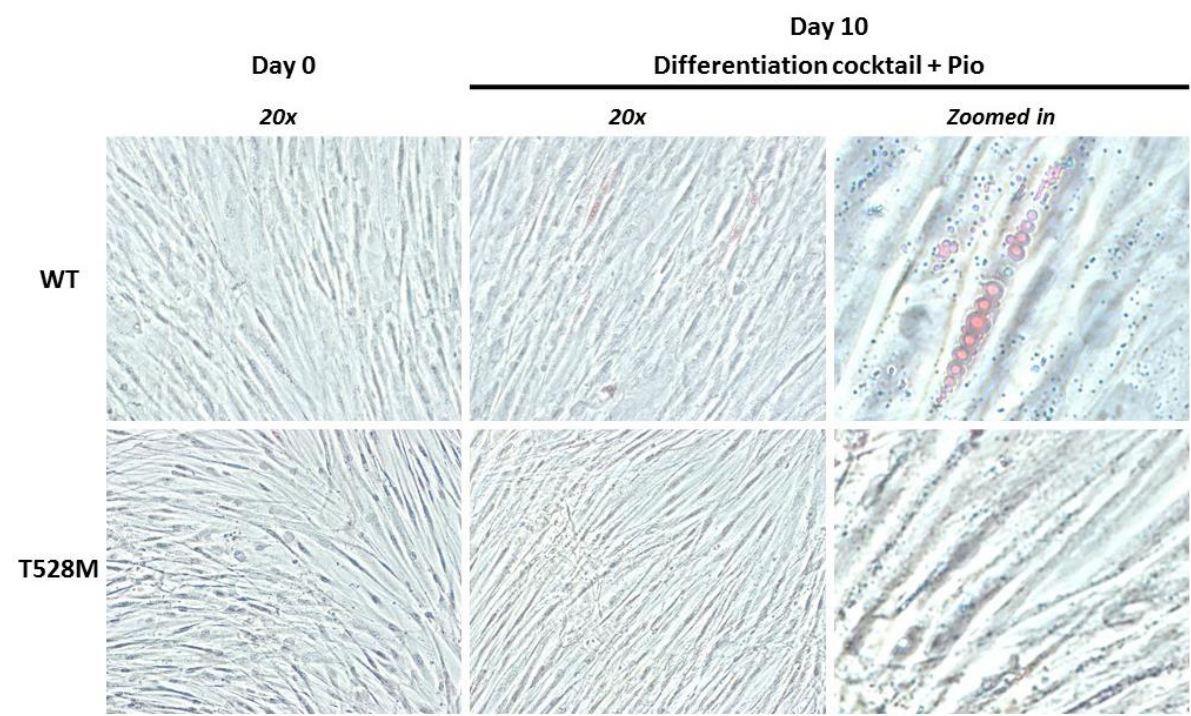
Figure 4. Representative photographs of lipid droplet formation in preadipocytes demonstrated by using Oil red O staining. Preadipocytes were induced for differentiation over 10 days into adipocytes with the differentiation cocktail containing pioglitazone. At day 10, after the induction of adipogenic differentiation, microphotographs were taken from a central area of a representative triplicate well. Phase contrast microscopy images were visualized under 20-fold magnification; 4-fold zoomed in areas are provided.